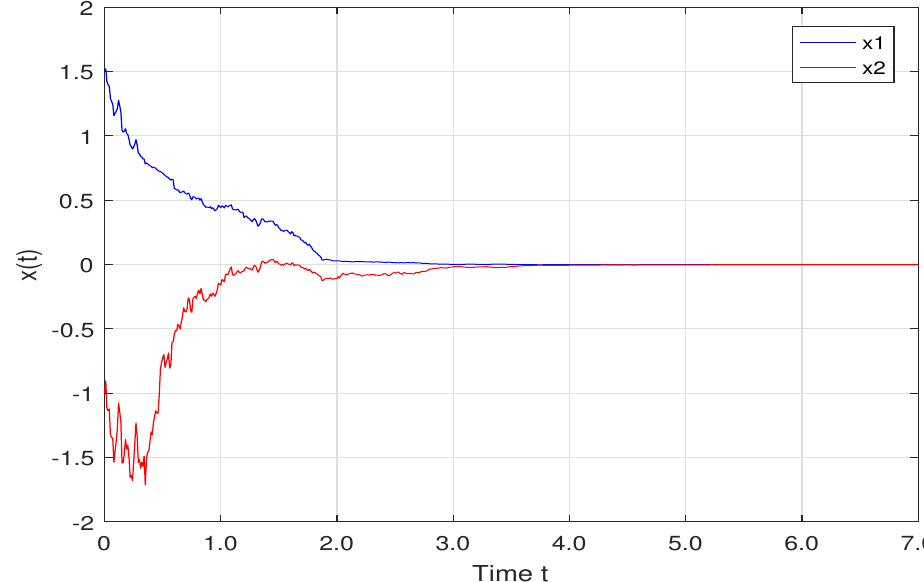
Figure 1. State trajectories of Example 1.